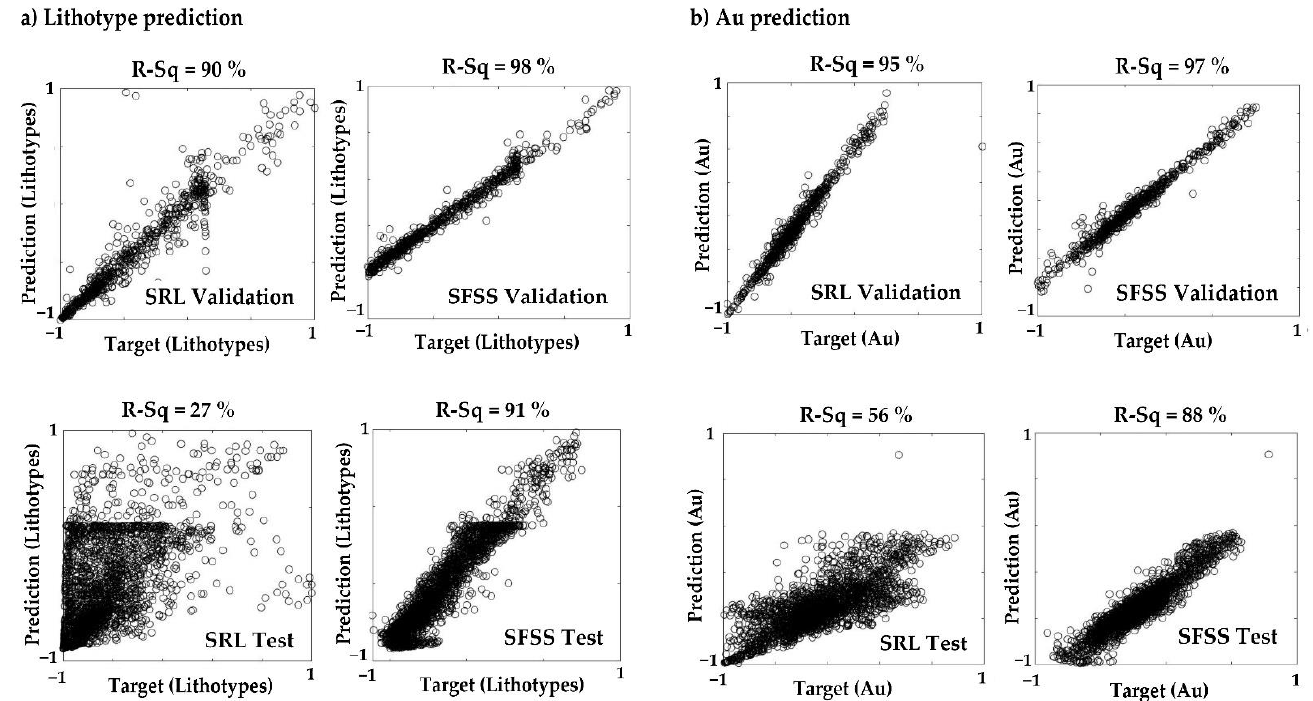
Figure 8. Evaluation of lithotype ( a ) and Au ( b ) predictive modeling for SRL and SFSS algorithms. R-sq denotes the R-squared values.